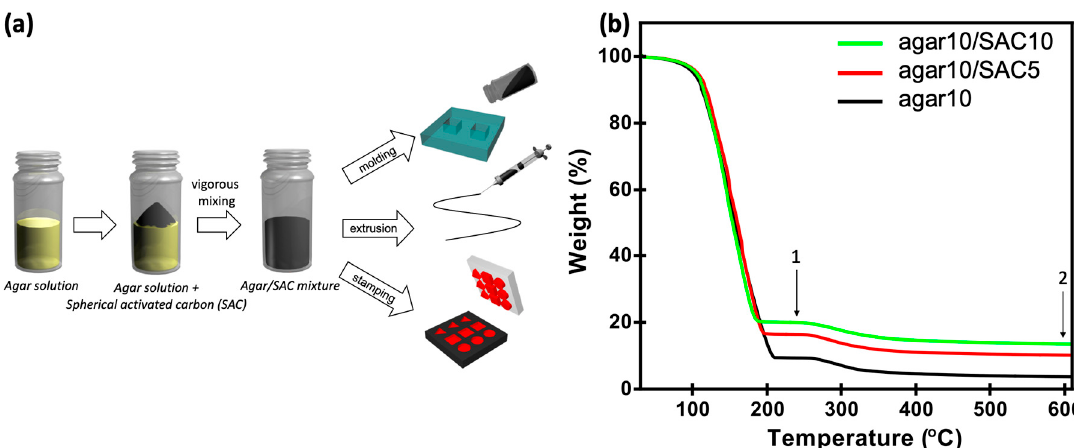
Figure 1. ( a ) Schematic diagram showing the preparation of the shape-configurable agarose and spherical activated carbon (agar/SAC) composite gels through various processes. ( b ) Thermogravimetric analysis (TGA) of the 10 wt % agarose gel as a control (agar10, black), 10 wt % agarose containing 5 wt % spherical activated carbon (agar10/SAC5, red), and 10 wt % agarose containing 10 wt % SAC (agar10/SAC10, green). Gels were fully dried near 230 °C (point 1), and agar was fully decomposed near 600 °C (point 2).